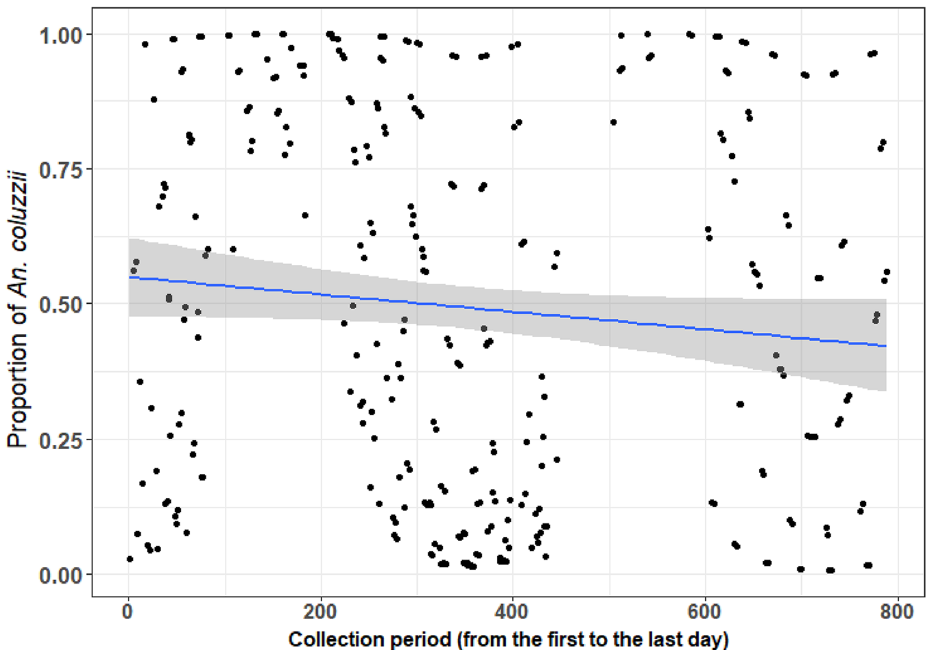
Figure 2. Mean predicted long-term trends in Anopheles coluzzii proportion within the An. gambiae complex from 12 villages in southwestern Burkina Faso. The blue line represents the predicted regression line from a model accounting for additional variation due to village and trapping location (inside and outdoors houses), with the grey-shaded area indicating the 95% confidence intervals.